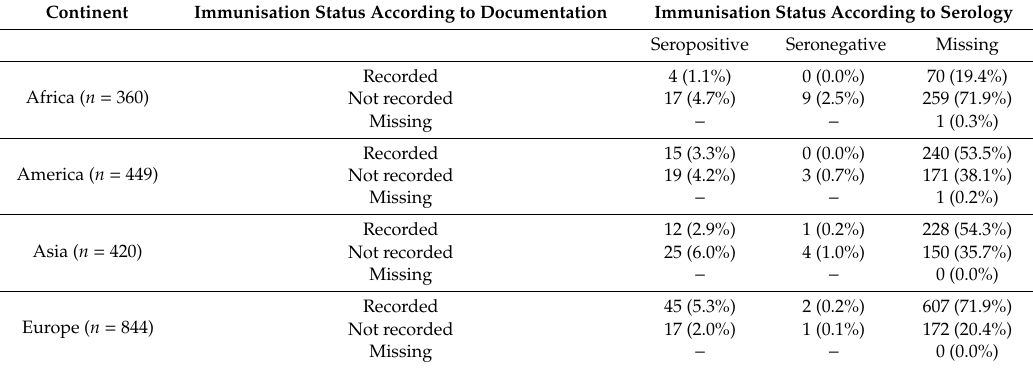
Table A2. Comparison between immunisation status of IAC reported in the documentation and serology for diphtheria, by continent of origin.